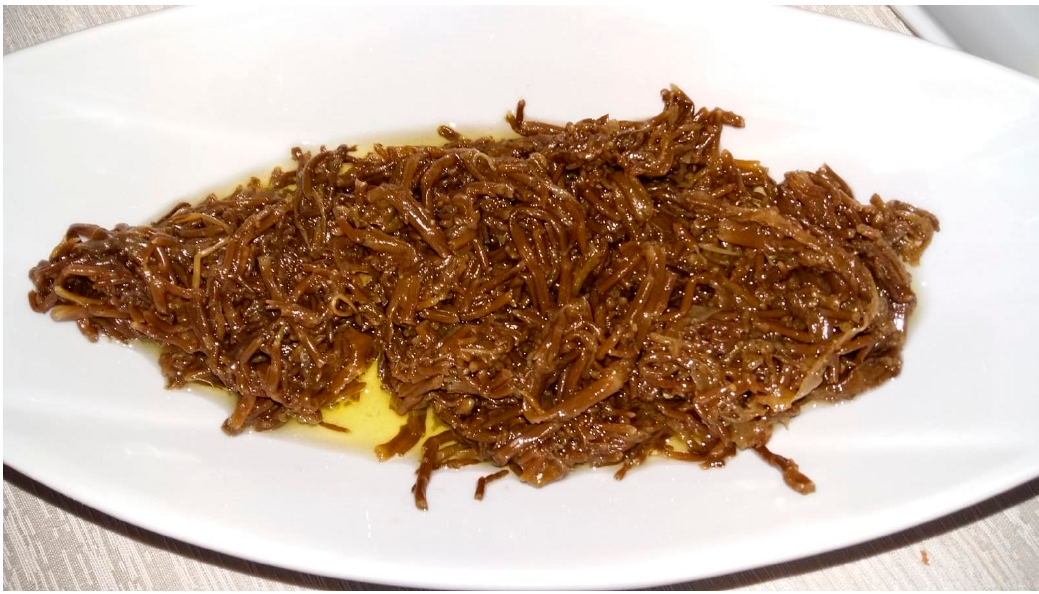
Figure 5. Apulian traditional dish: boiled Salicornia with extra-virgin olive oil and garlic. S. europaea L. is currently included in the list of traditional Apulian